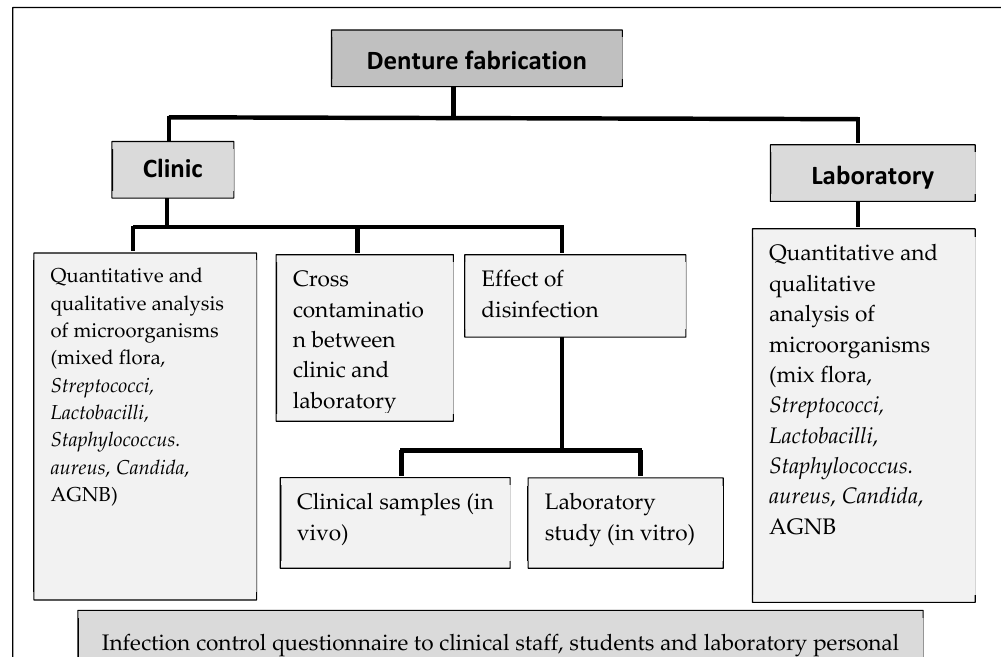
Figure 1. Flow diagram of the study design. AGNB: aerobic Gram-negative bacteria.